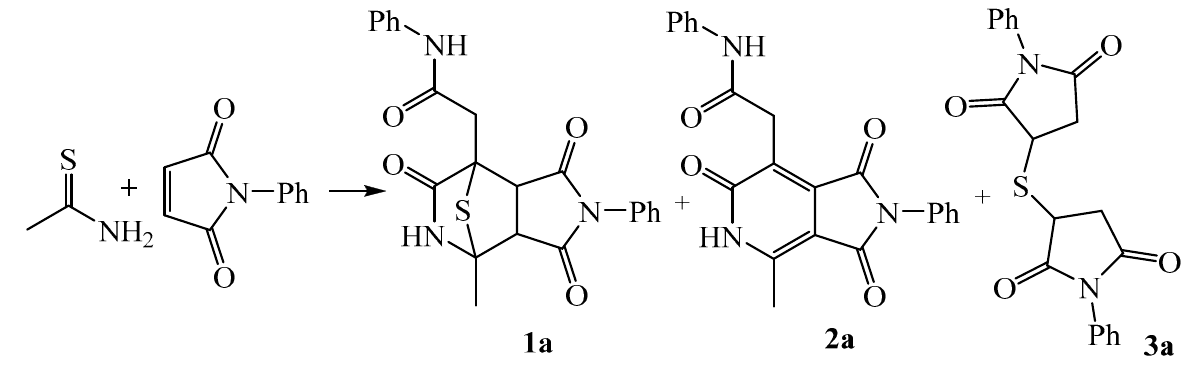
Scheme 3. Reaction products of thioacetamide and